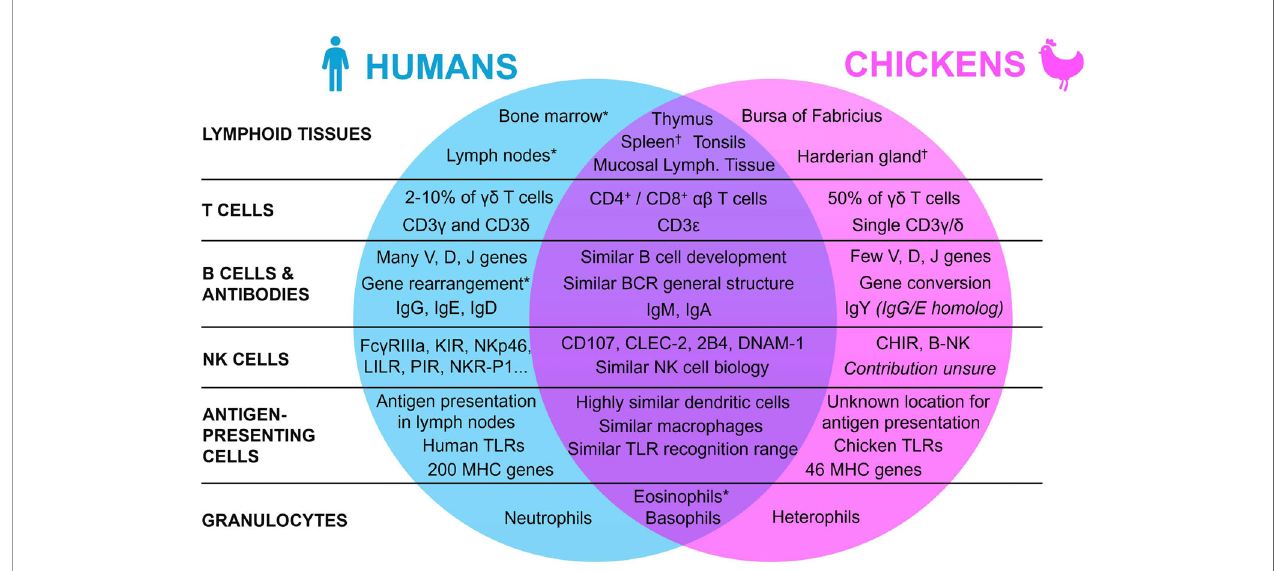
FIGURE 1 | Summary of the similarities and differences between the human and the chicken immune systems. * Present in both species, with a lower contribution in chickens. † Present in both species, with a lower contribution in